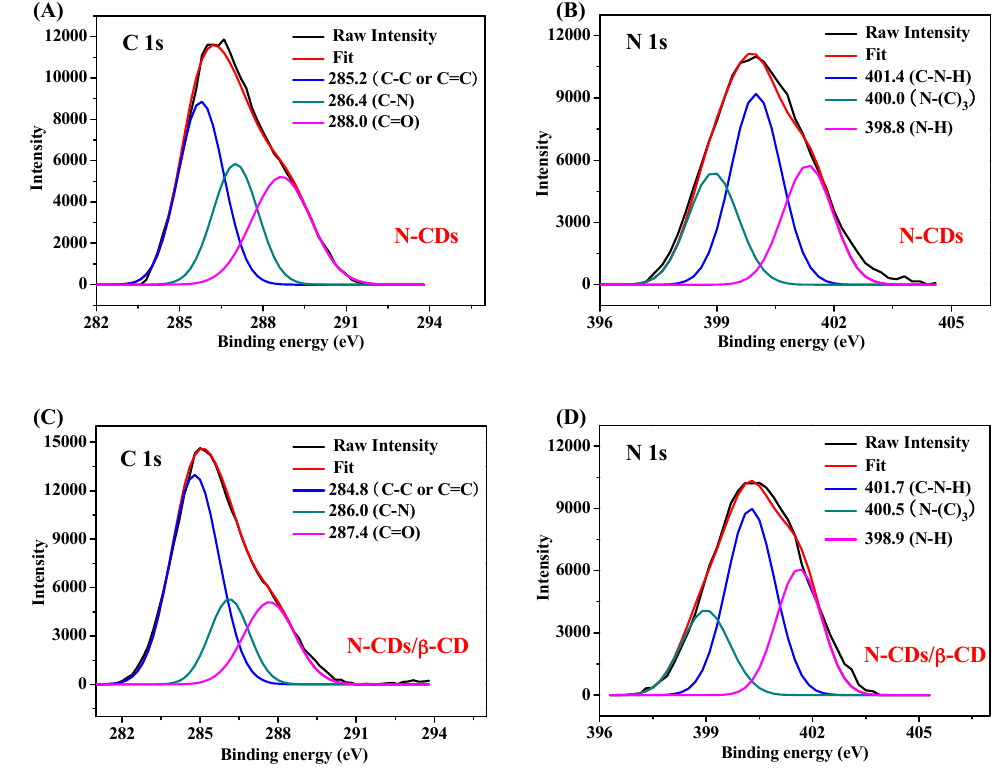
Figure 2. High-resolution C 1s ( A ) and N 1s ( B ) XPS spectra of N-CDs; High-resolution C 1s ( C ) and N 1s ( D ) XPS spectra of N-CDs/ β -CD nanocomposites.